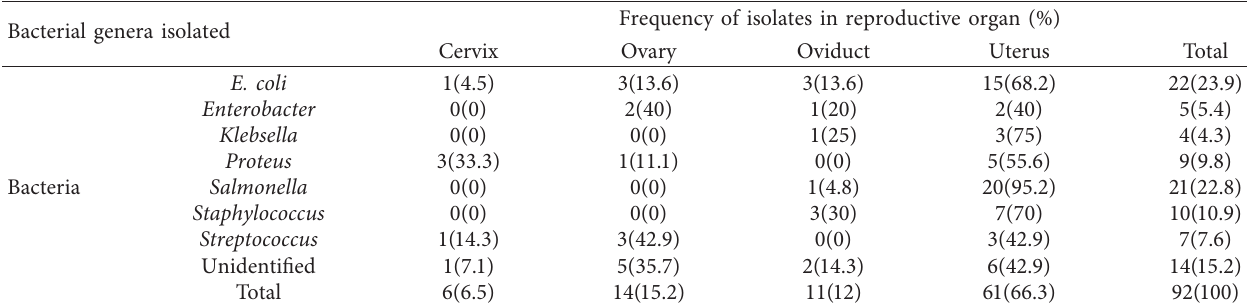
Table 5: Frequency of bacterial organisms isolated from reproductive organs of she-camels. Frequency of isolates in reproductive organ Bacterial genera isolated